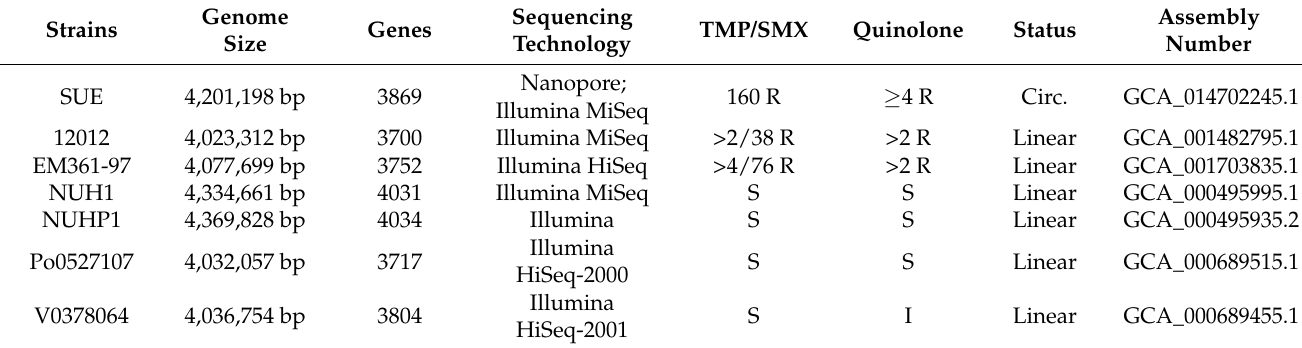
Table 3. Comparison of seven Elizabethkingia anophelis genomes and antibiotic